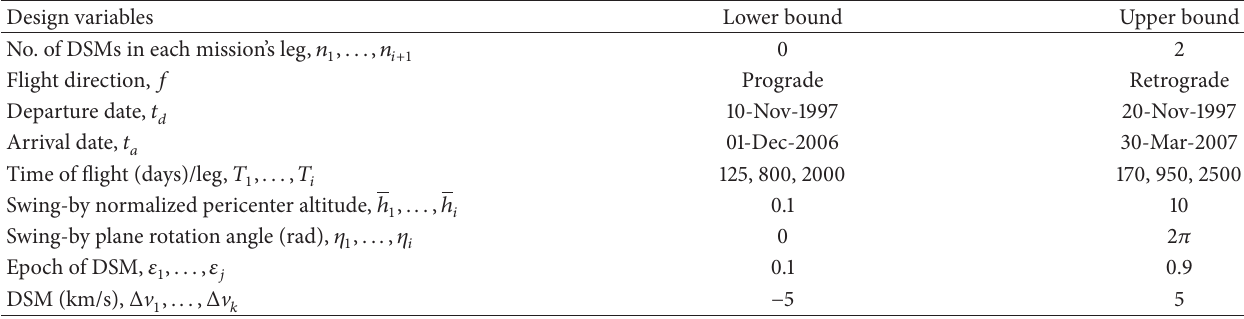
Table 11: Bounds of Cassini 2 mission’s design variables: second optimization phase.